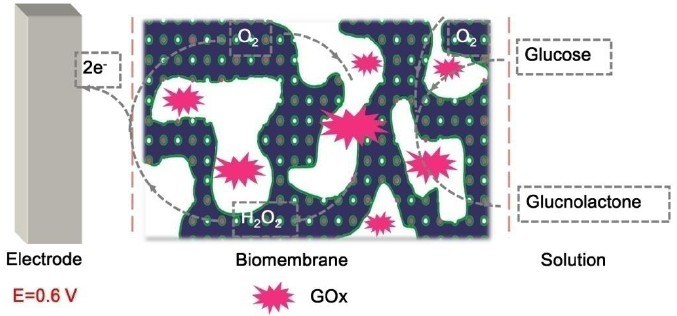
Figure 5. The schematic reaction mechanism of glucose biosensor.